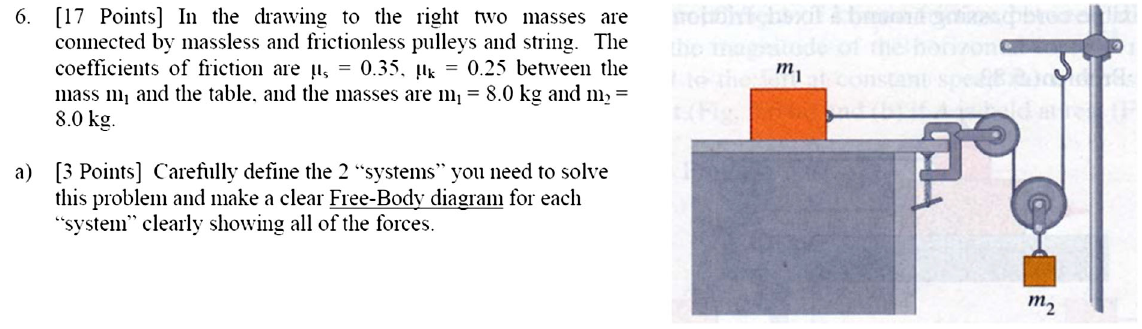
FIG. 2. A sample exam problem from TP